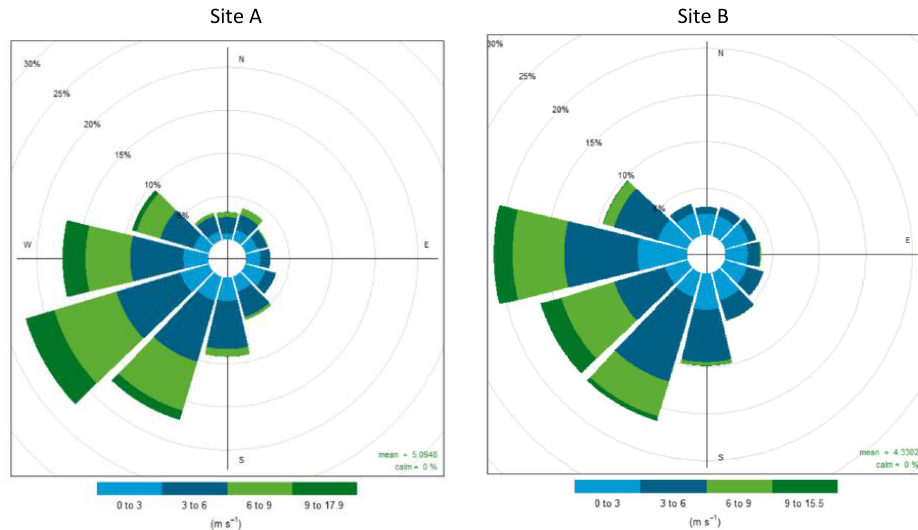
Figure A6. Wind speed and wind directions for all sampled events at test sites A and B.